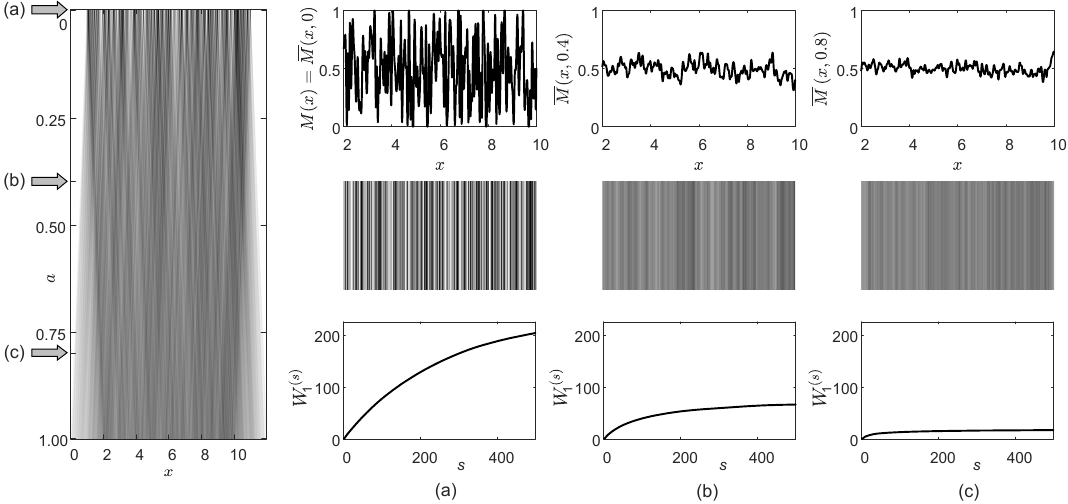
Figure 3. Harmonic oscillations of a random moiré grating produce optical motion-induced blur in the time-averaged image. Time-averaged random moiré gratings are depicted in the left panel at increasing values of amplitude a . Time-averaged random moiré gratings, their optical representations, ( s ) and their Wada indexes W are shown at a = 0 (panel ( a )), a = 0.4 (panel ( b )), and a = 0.8 (panel ( c 1